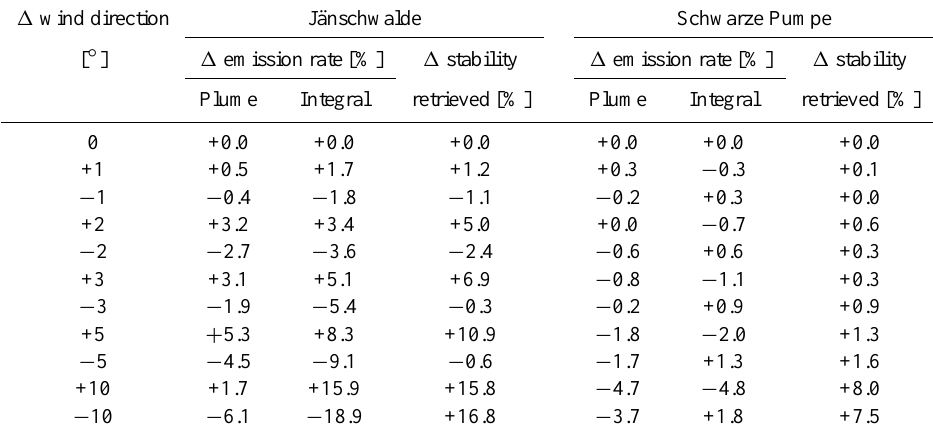
Table 11. Systematic errors in emission rate and stability parameter a caused by choosing a wrong wind direction for plume model and Gaussian integral inversion of simulations of the J¨anschwalde and Schwarze Pumpe power plant overflight. Default wind direction for the simulated data was 228 ◦ (J¨anschwalde) and 210 ◦ (Schwarze Pumpe), default stabilities assumed for the simulation same as the retrieved stabilities for J¨anschwalde and Schwarze Pumpe in Table 10. The results for the integral inversion have already been corrected for the systematic error due to the flight pattern. 1 wind direction J¨anschwalde